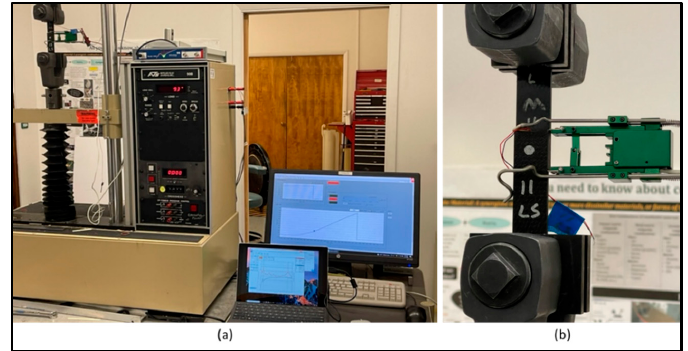
Figure 12. ATS 900 test system with coupon loaded. ( a ) Test setup, ( b ) coupon